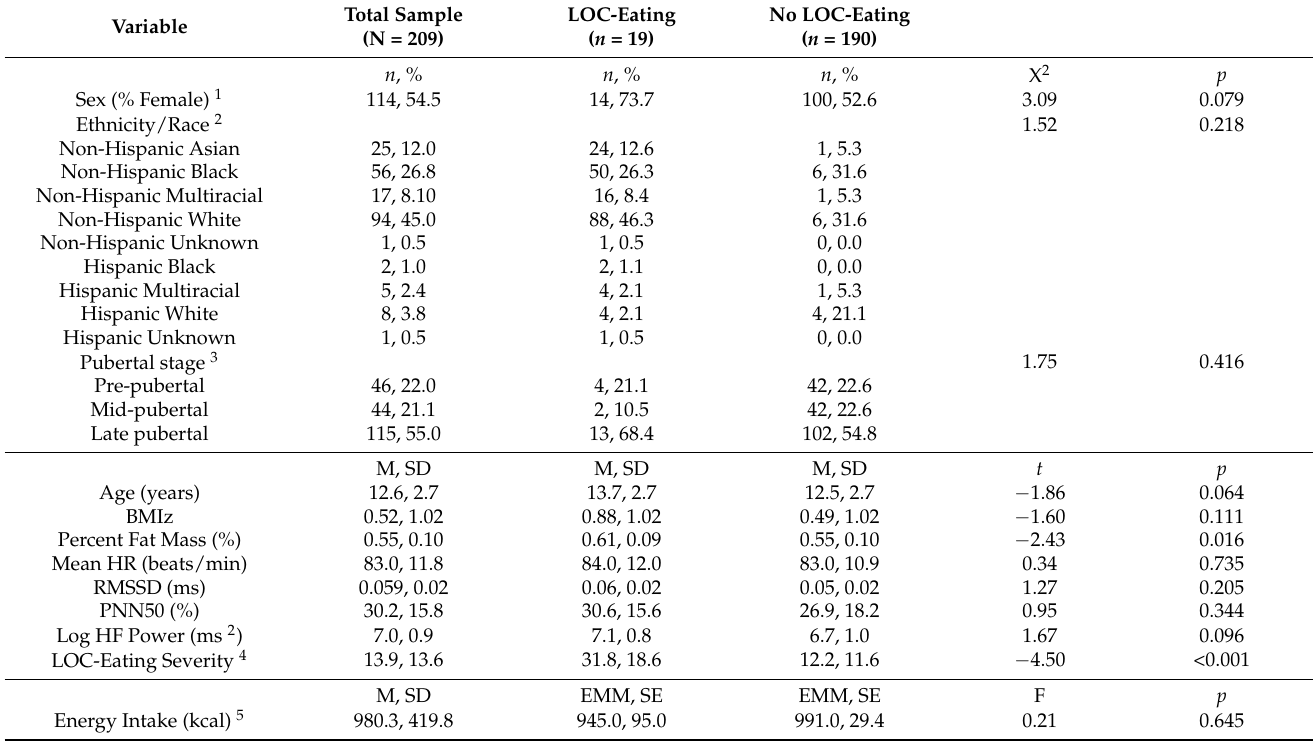
Table 1. Participant characteristics and descriptive